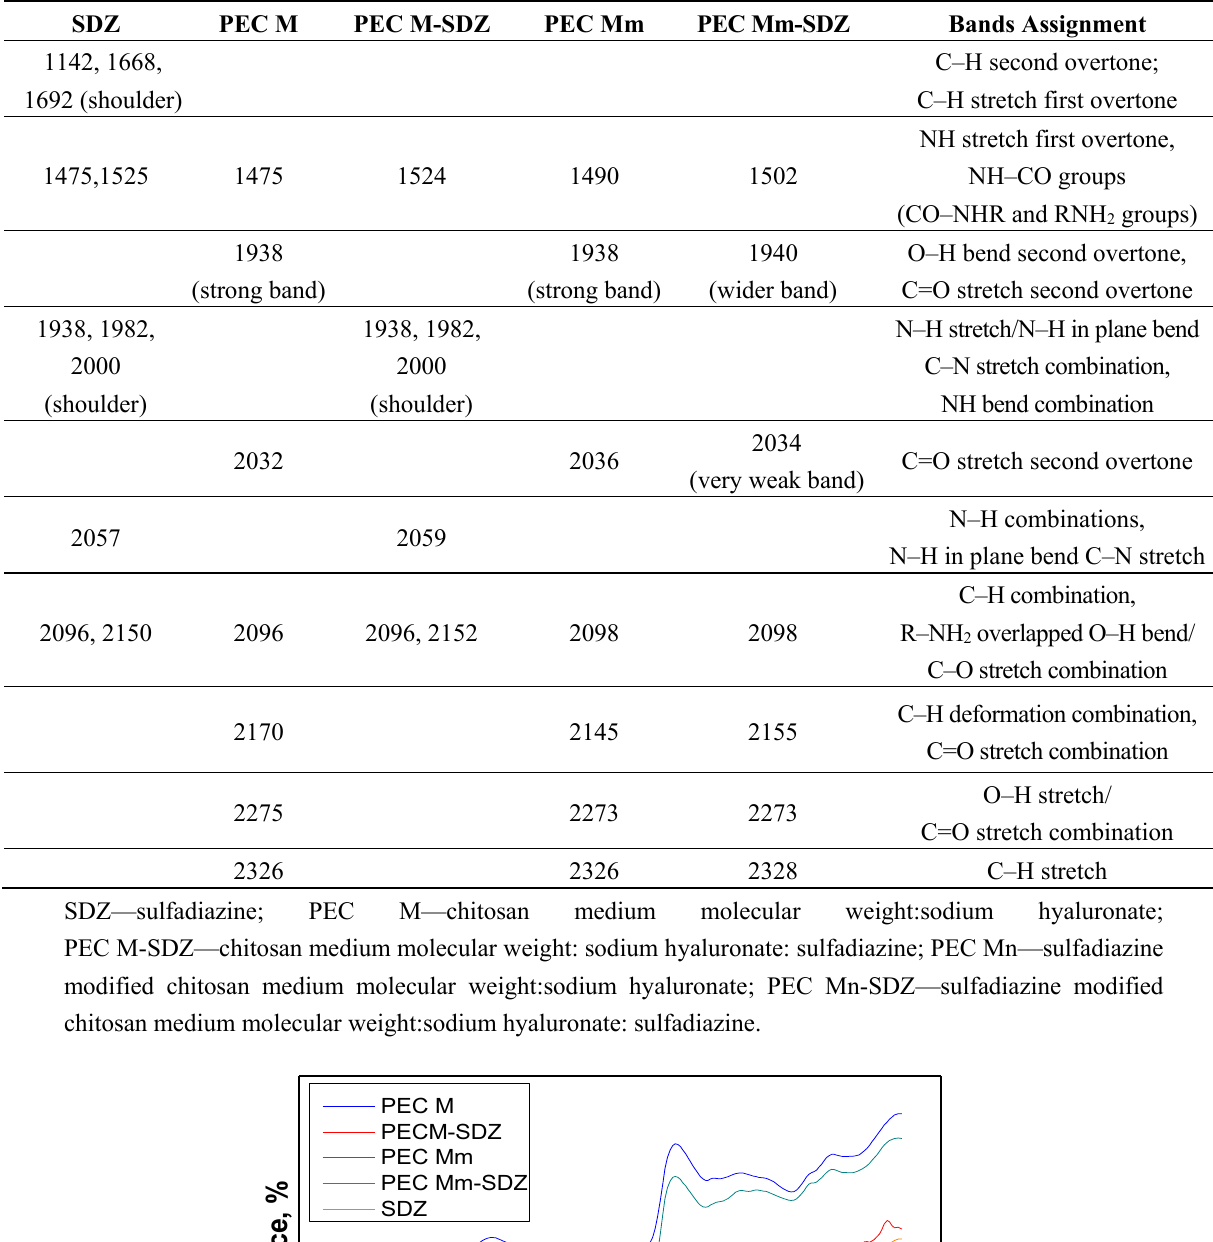
Table 3. NIR-CI spectra bands (nm) assignment [34,35].